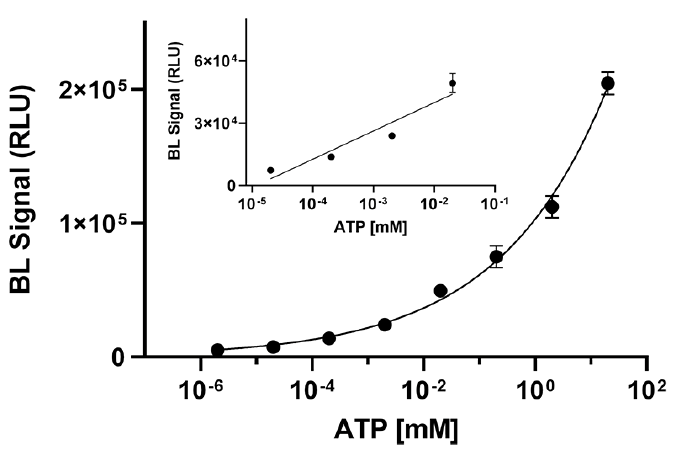
Figure 4. Calibration curve for ATP detection obtained with BgLuc luciferase (6 µ L of a 0.5 mg/mL solution). The measurements were performed in triplicate and repeated at least three times.